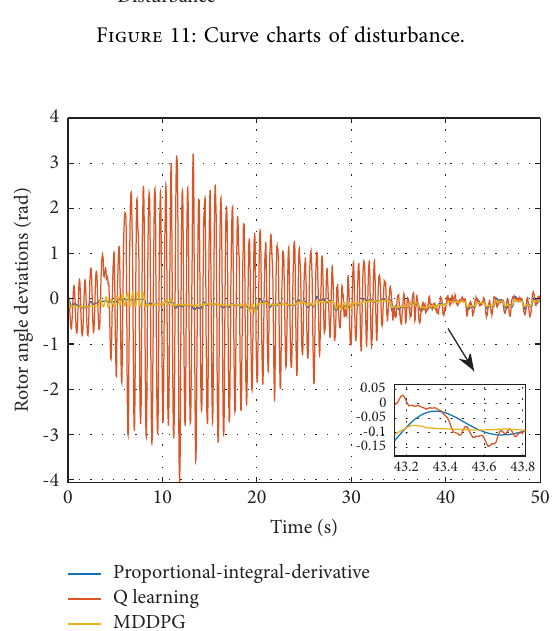
Figure 13: Controller output curves obtained by compared